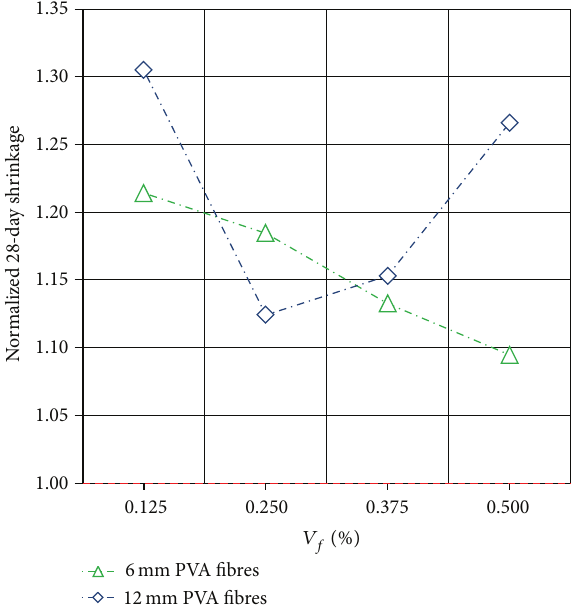
Figure 11: Normalized shrinkage of FRC at 112 days with respect to the control concrete.